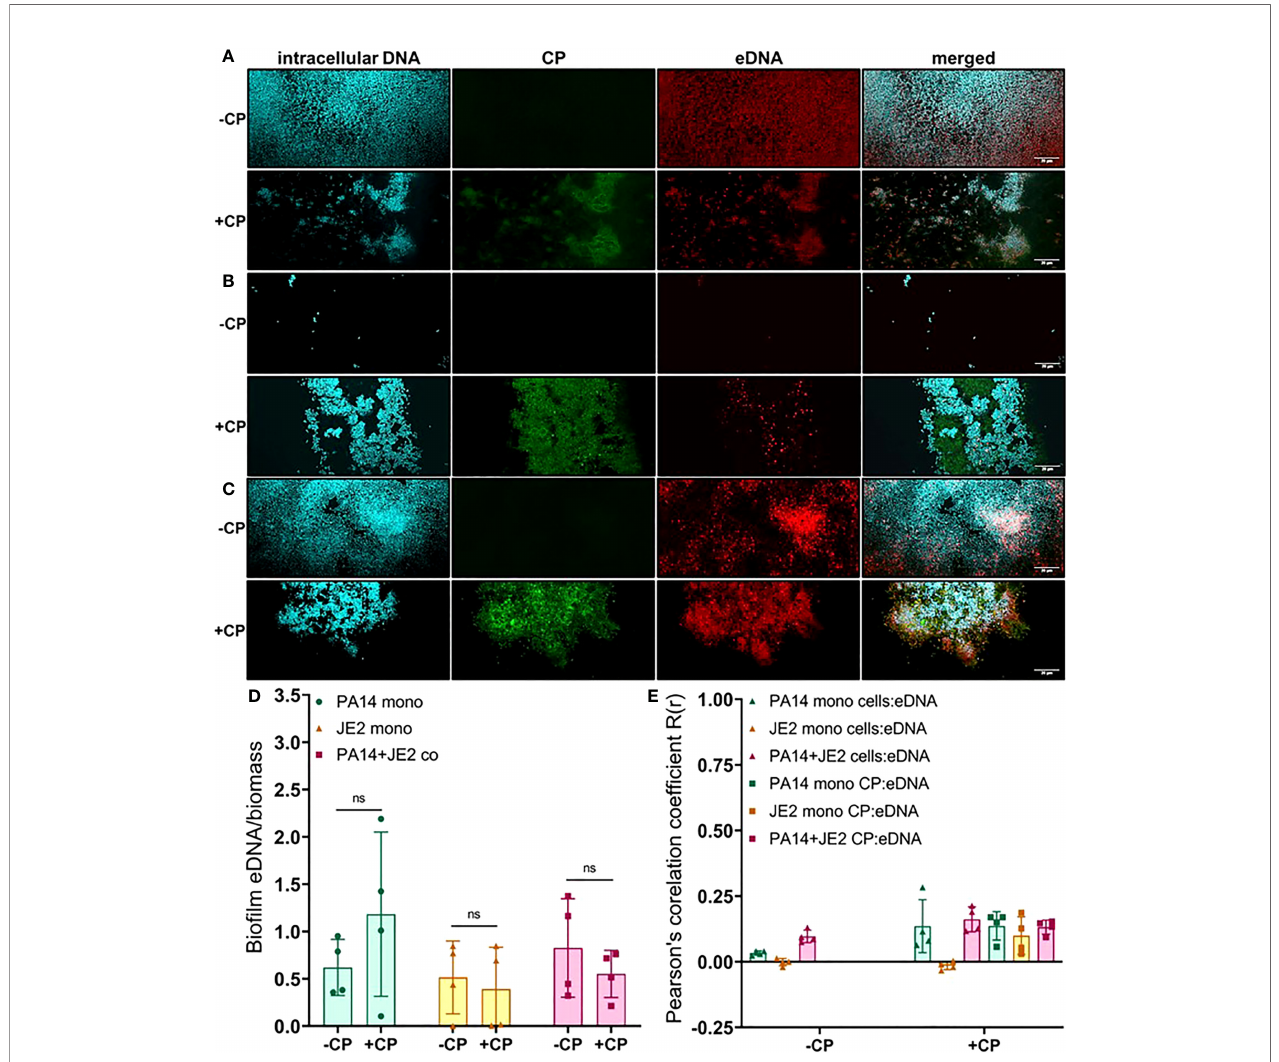
FIGURE 4 | Addition of CP minimally impacts the relative abundance of eDNA in bio fi lm matrices of P. aeruginosa and S. aureus. This fi gure depicts confocal images that represent abundance of eDNA in P. aeruginosa and/or S. aureus bio fi lm communities in presence or absence of CP conditions. The fl uorescence dyes Hoechst 33342, Alexa 488, and TOTO-3 iodide correspond to intracellular DNA of microbial cells, CP, and eDNA in the bio fi lm EPS matrix of- (A) P. aeruginosa monoculture (B) S. aureus monoculture (C) P. aeruginosa - S. aureus co-culture. (D) Quanti fi cation of eDNA per biomass in P. aeruginosa and S. aureus bio fi lms in presence or absence of CP. (E) Colocalization analysis of eDNA signals with cells and CP show minimal correlation of distribution of eDNA with cells and/or CP. Images show 100X magni fi cation and were processed using ImageJ. Bars represent the mean of four biological replicates performed on two independent days. Error bars represent the standard error of mean of the biological replicates. Unpaired t-test (two-tailed) was used to measure statistical signi fi cance. Comparisons marked ns denote changes that were not found to be statistically signi fi